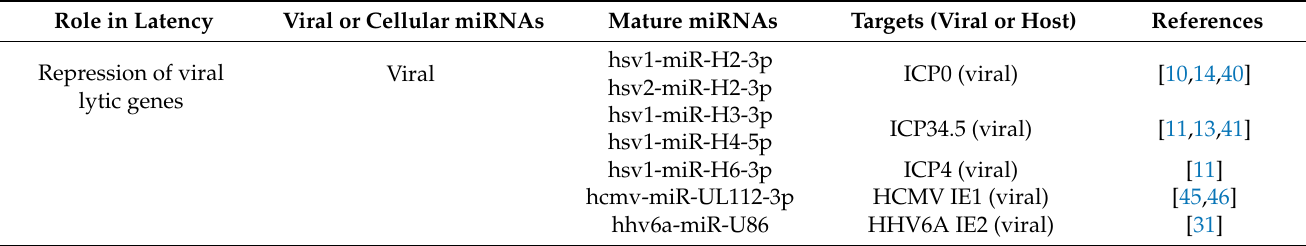
Table 1. miRNAs with potential role in herpesvirus